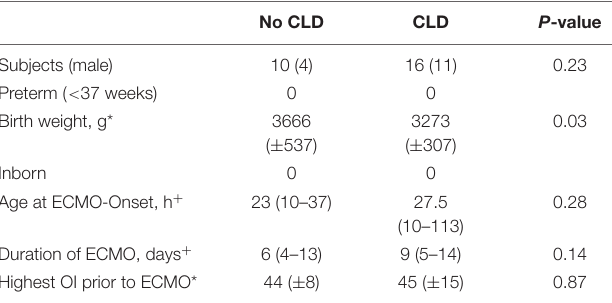
TABLE 3 | Comparison of clinical perinatal characteristics in patients with meconium aspiration syndrome between those with and without chronic lung